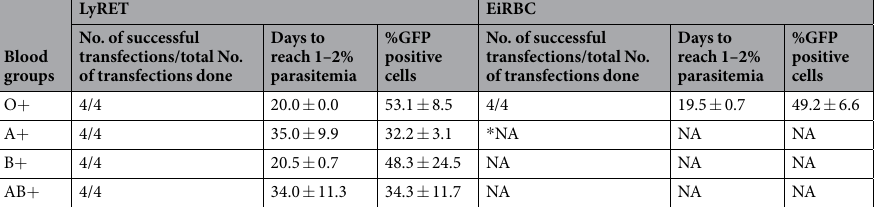
Table 3. Transfection of P. falciparum 3D7 with pPfCENv3 using RBCs of different blood groups by the LyRET method. Each transfection experiment was independently performed. The days to reach 1–2% parasitemia is mean with SD of the days required for emergence of resistant parasites in successful experiments. The %GFP positive cells was determined by FACS and is mean with SD of GFP-Hoechst positive cells in all the successful experiments. * NA indicates “Not